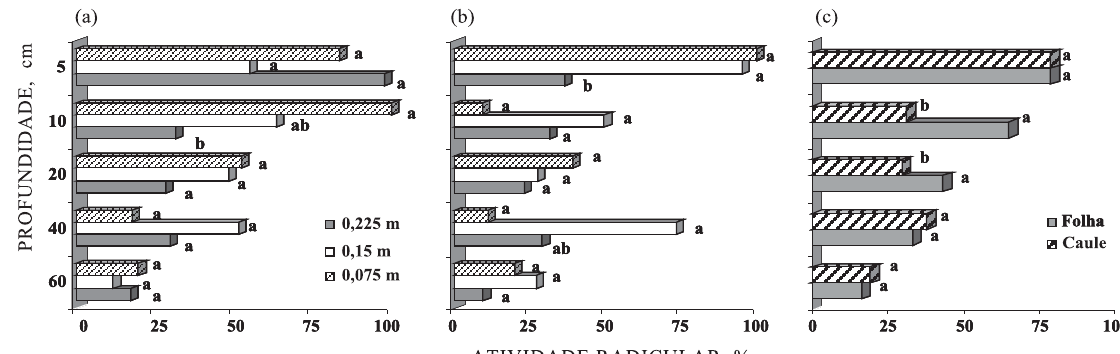
Figura 1. Atividade radicular estimada de plantas de soja aos quatro dias após a aplicação de 3 mL de RbNO na dose de 1 mg dm -3 , a 0,075, 0,15 e 0,225 m de distância da planta e a 0,05; 0,10; 0,20; 0,40; e 3 0,60 m de profundidade: (a) obtida pelo teor de rubídio em folhas; (b) obtida pelo teor de rubídio no caule; e (c) obtida com as médias dos teores de rubídio em folhas e no